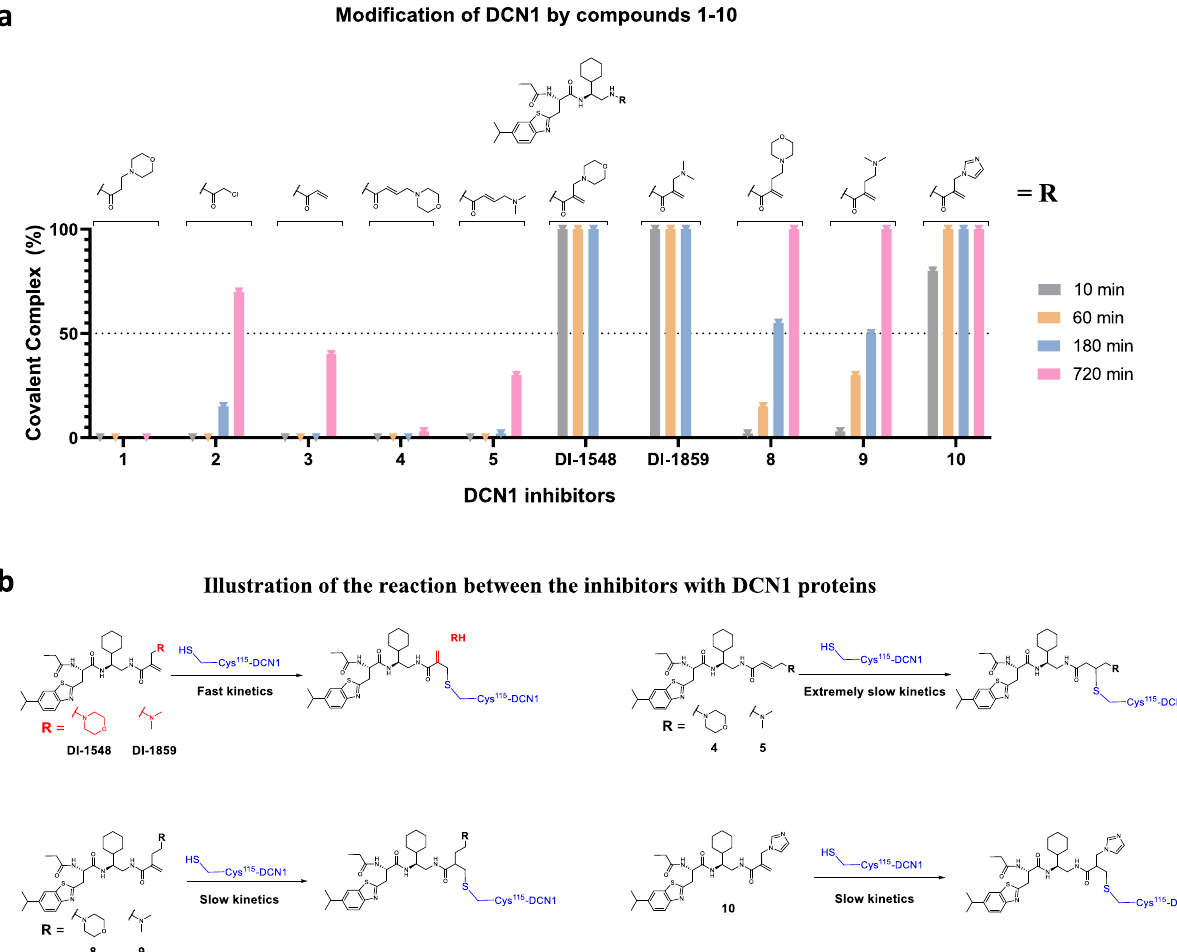
Fig. 2 Mass spectrometric characterization of the reactivity of covalent DCN1 inhibitors with recombinant human DCN1. a Percentage of the formation of covalent complex between the DCN1 protein and the indicated compounds based on the intact ESI mass spectrometric analyses at different time points. The mass spectra are provided in Supplementary Figs. 1 – 11. Source data are provided as a Source Data fi le. b Illustration of the reaction between the inhibitors with DCN1 protein based on mass spectrometry